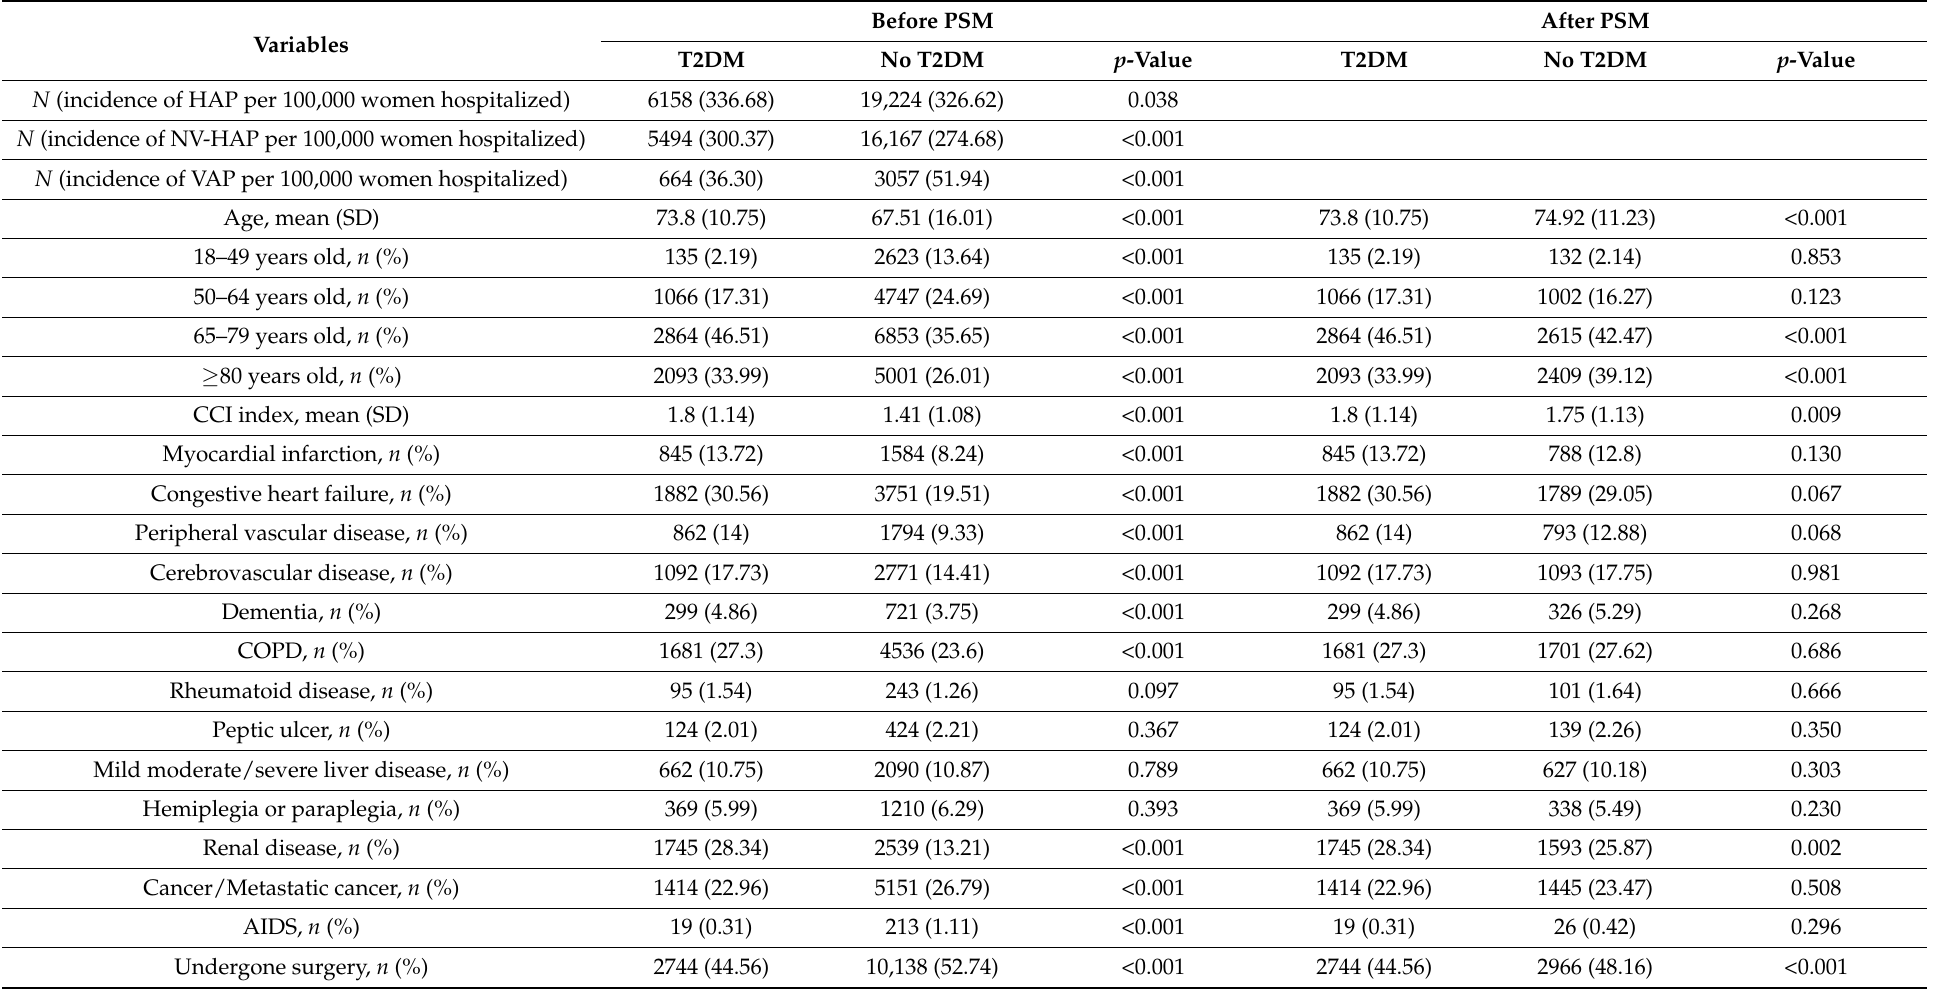
Table 3. Distribution of study covariates and hospital outcomes of men with and without T2DM who developed hospital-acquired pneumonia (HAP) in Spain (2016–2019), before and after propensity score matching